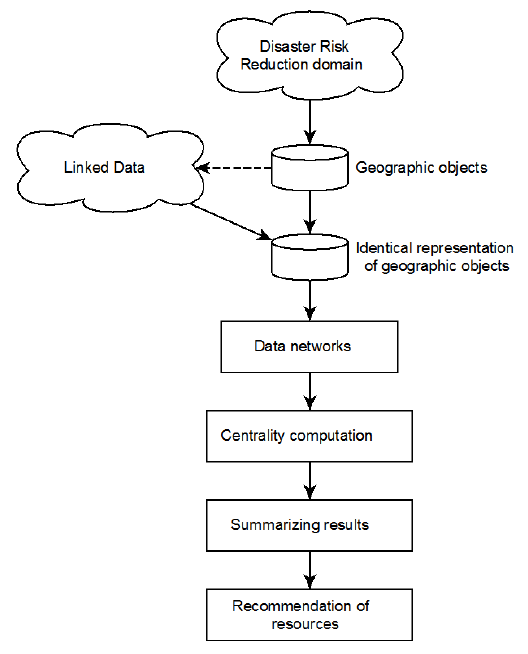
Figure 1. The workflow of the research.